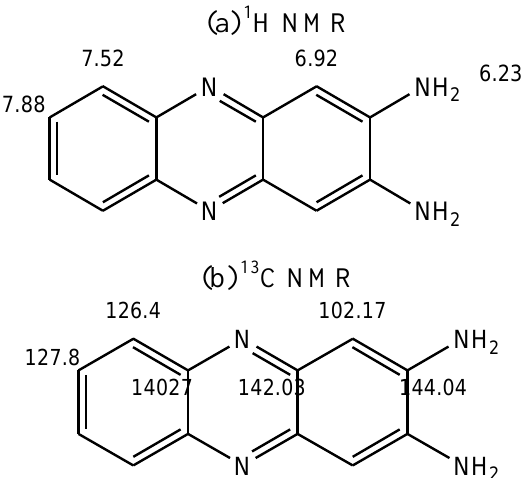
Figure 5. Attribution of 1 H– 13 C HSQC